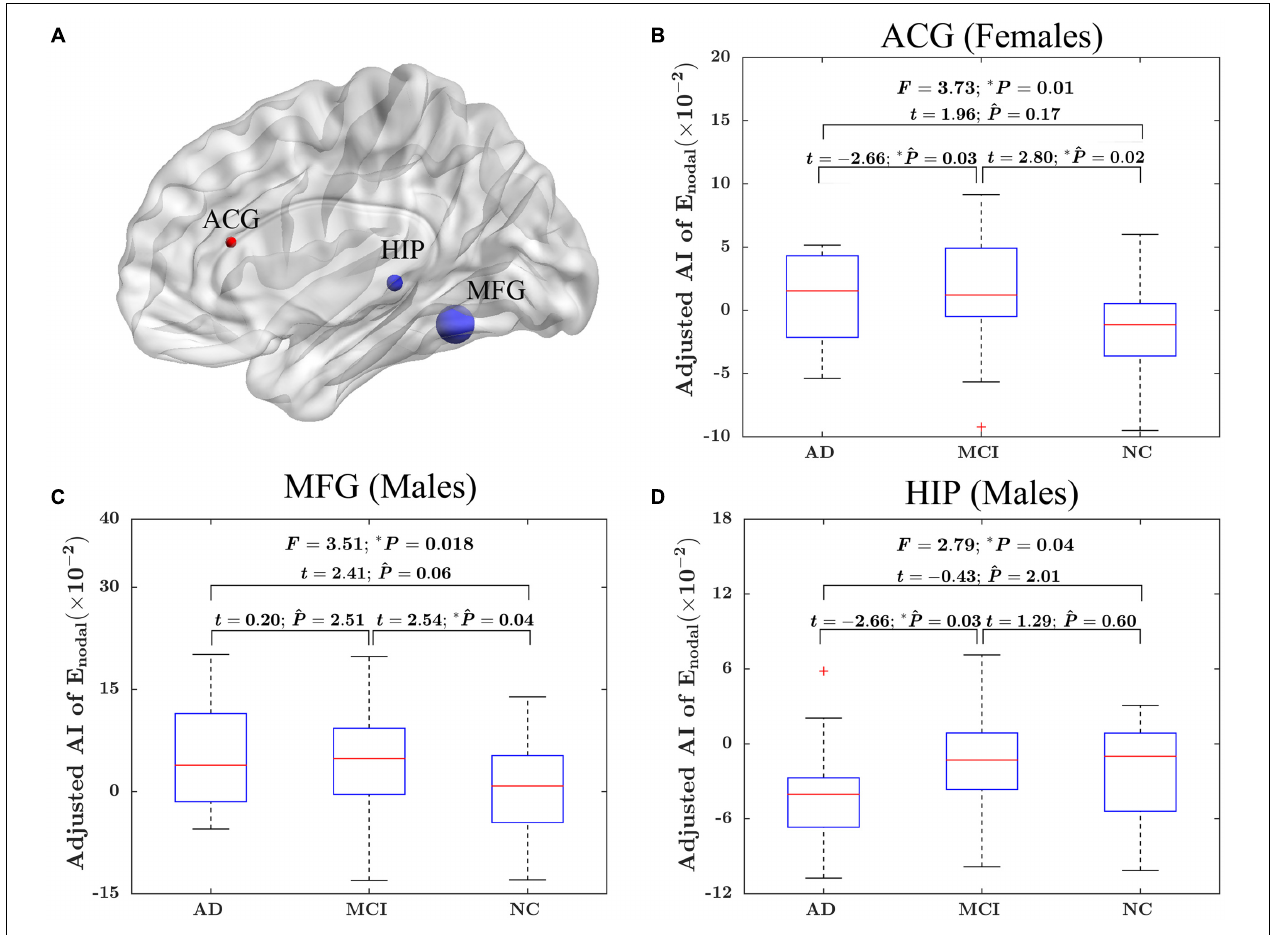
FIGURE 5 | The “sex × group” interaction effects on the AI of nodal efficiency. (A) Three-dimensional representations of the significant “sex × group” interaction effects on AI of nodal efficiency (uncorrected P < 0.05), The nodes in blue represent the significant difference in males, and the node in red represents significant difference in females. The node size represents the F value when comparing the AI of nodal efficiency among the three groups. (B) The box plots of the “sex × group” interaction effects on the AI of nodal efficiency in ACG in females. (C) The box plots of the “sex × group” interaction effects on the AI of nodal efficiency in MFG in males. (D) The box plots of the “sex × group” interaction effects on the AI of nodal efficiency in HIP in males. Before conducting the group comparisons, the data were adjusted for whole-brain ICV, hemispheric ICV difference, age, and TR and TE from diffusion-weighted imaging. ˆP represents the Bonferroni-corrected P -value of post hoc